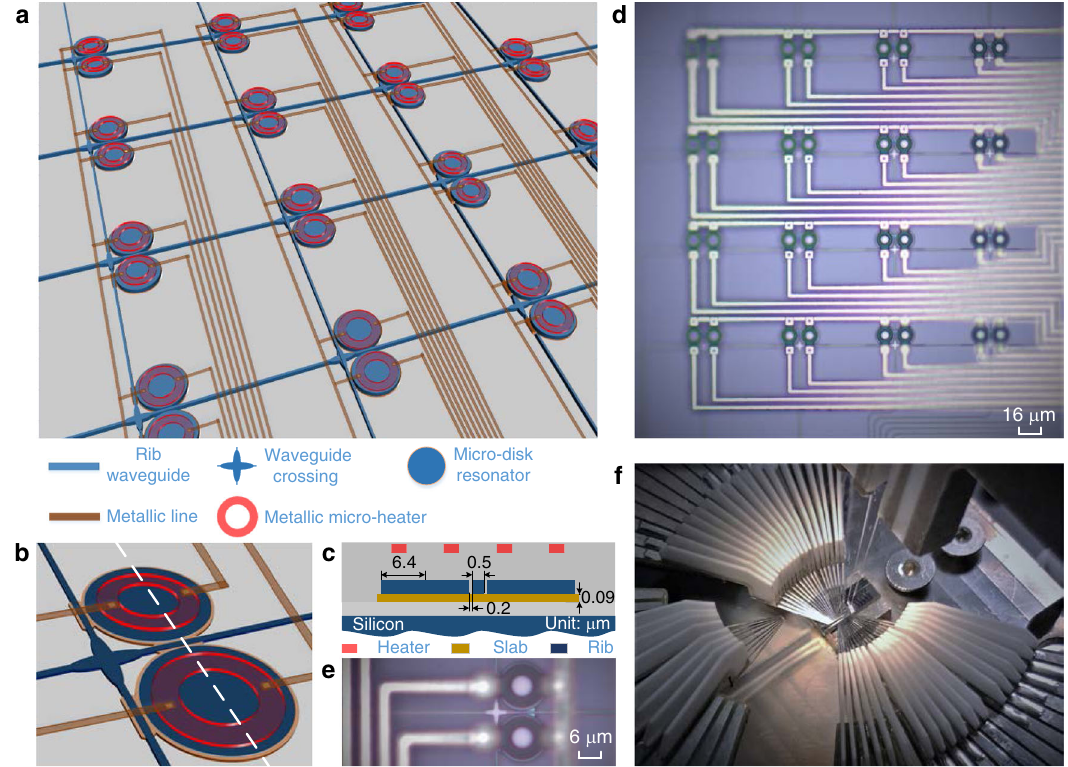
Fig. 1 Scalable photonic integrated FPDA signal processor. a Schematic layout of the proposed FPDA signal processor. b Zoom-in view of a singe mesh cell. c Cross-sectional view of the planar structure of two disks along the white dash line in b . d Chip prototype of an 8 × 8 FPDA signal processor. e Zoom- in view of a single mesh cell. f Image of the chip characterization